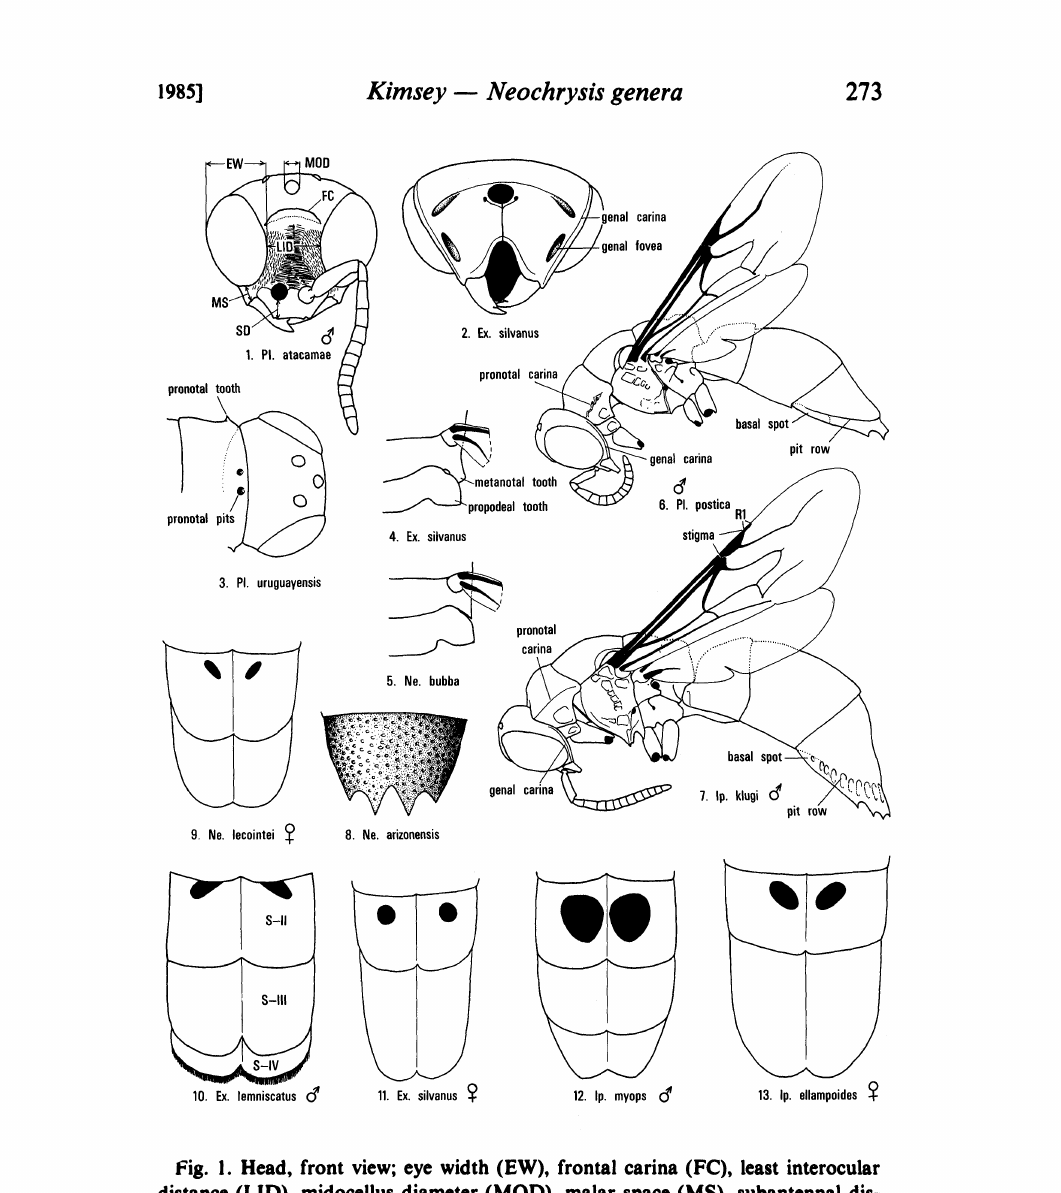
Fig. 1. Head, front view; eye width (EW), frontal carina (FC), least interocular distance (LID), midocellus diameter (MOD), malar space (MS), subantennal dis- tance (SD). Fig. 2. Head, posterior view. Fig. 3. Head and pronotum, dorsal view. Figs. 4-5. Right side of metanotum and propodeum, dorsal view. Figs. 6-7. Body with legs removed, lateral view. Fig. 8. Tergum III, dorsal view. Figs. 9-13. Sterna II-111 (females) and IV (males).